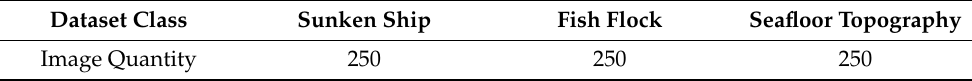
Table 1. Detailed description of the datasets.